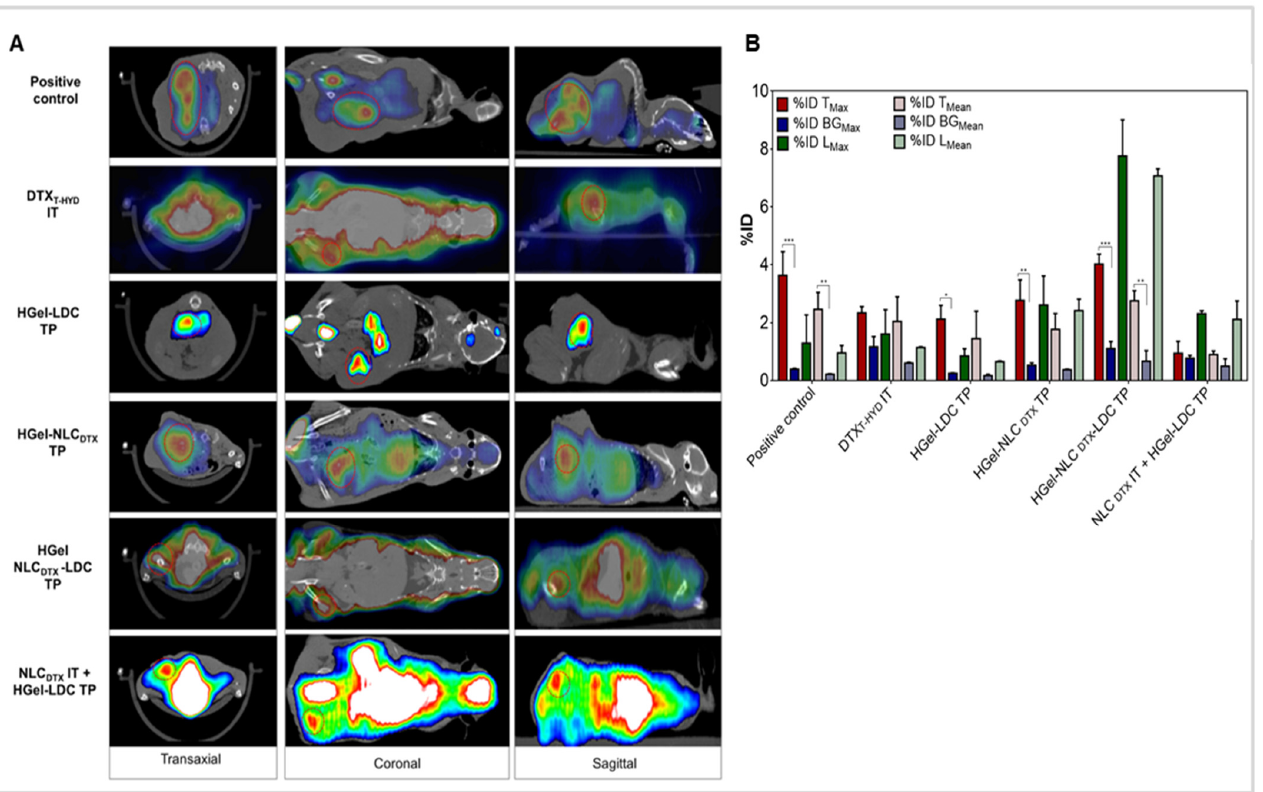
Figure 5. Micro-PET/CT imaging showing 18 F-[FDG] uptake in mice with B16-F10 tumors treated with saline (Positive control), free docetaxel (DTX T-HYD) and hydrogel formulations (HGel-LDC, HGel-NLC DTX TP, HGel-NLC DTX -LDC TP and NLC DTX IT + HGel-LDC TP). ( A ) Images taken 7 days after the end of the treatments. Additional identifiable structures with respect to 18 F-[FDG] uptake were bladder, kidney, liver and heart. Dashed circles indicate the location of the tumor. ( B ) Quantification of 18 F-[FDG] uptake (%ID Max and ID% Mean , mean ± SD, n =2) in tumors (T), normal adjacent tissue (BG) and liver (L). The%ID Max of the tumor (%ID T Max ) was compared to the%ID Max –BG (%ID BG Max ) to better assess the injected dose activity. Raw values are shown in Table S3. The%ID Max –liver (%ID L Max ) and%ID Mean –liver (%ID L Mean served as a reference for high 18 F-[FDG] uptake. Statistical analysis: Two-Way ANOVA post-hoc Tukey, * p < 0.05; ** p < 0.01; *** p < 0.001.